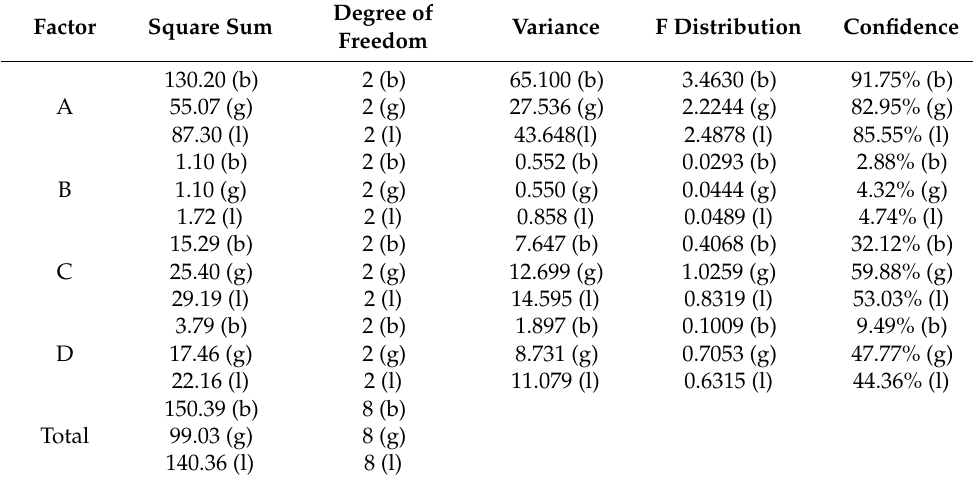
Table 6. Variance analysis of S/N ratio of base (b), gear (g), and linkage (l) parts for the MAV.